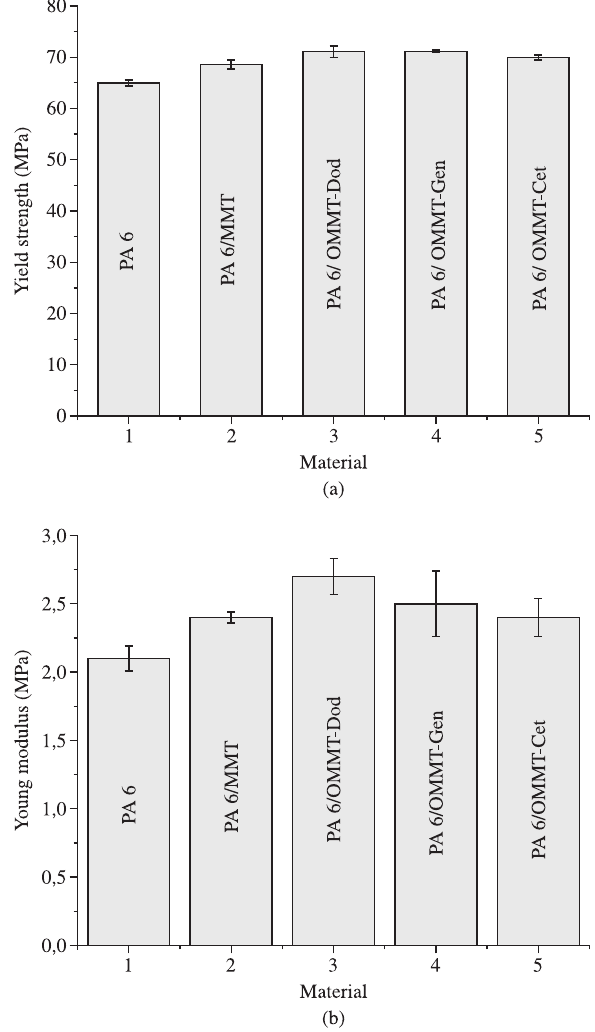
Figure 3. Mechanical properties of polyamide 6 and its nanocomposites a) yield strength; and b) young modulus.